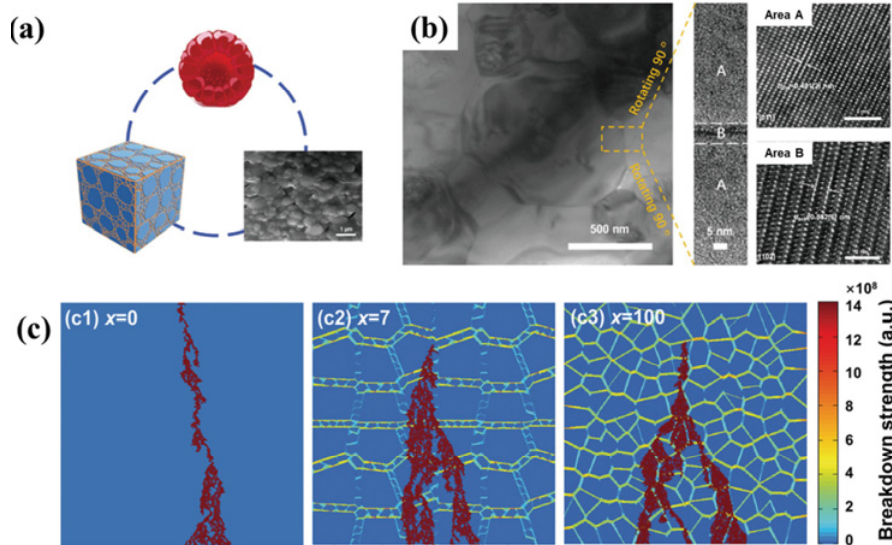
Fig. 14 (a) Raspberry-like hierarchically structures of BBS x ceramics. (b) Representative bright-field TEM image of the BBS7 ceramics. (c) Breakdown paths of BBS x ceramics ( x = 0, 7, and 100) simulated by the finite element method. Reproduced with permission from Ref. [28], © WILEY-VCH Verlag GmbH & Co. KGaA, Weinheim